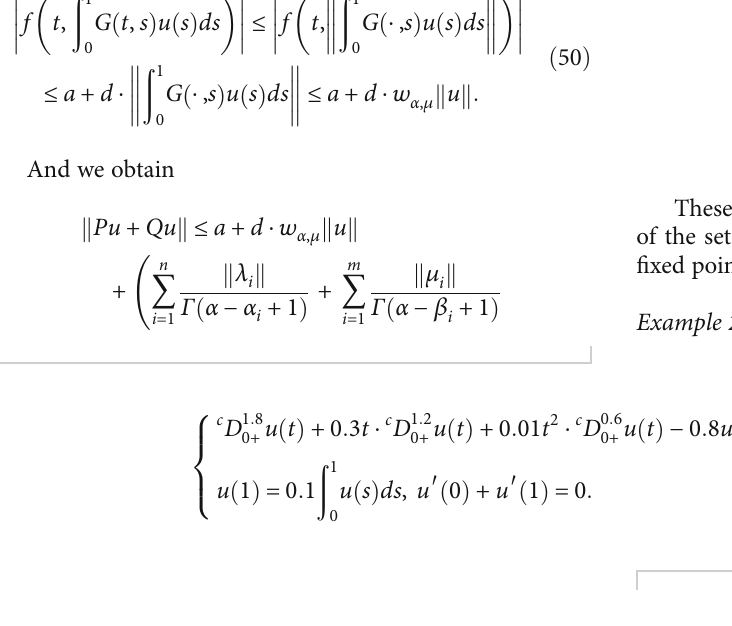
ffiffiffiffiffiffiffiffiffiffiffiffiffiffiffiffiffi 1 + u 2 t ð Þ